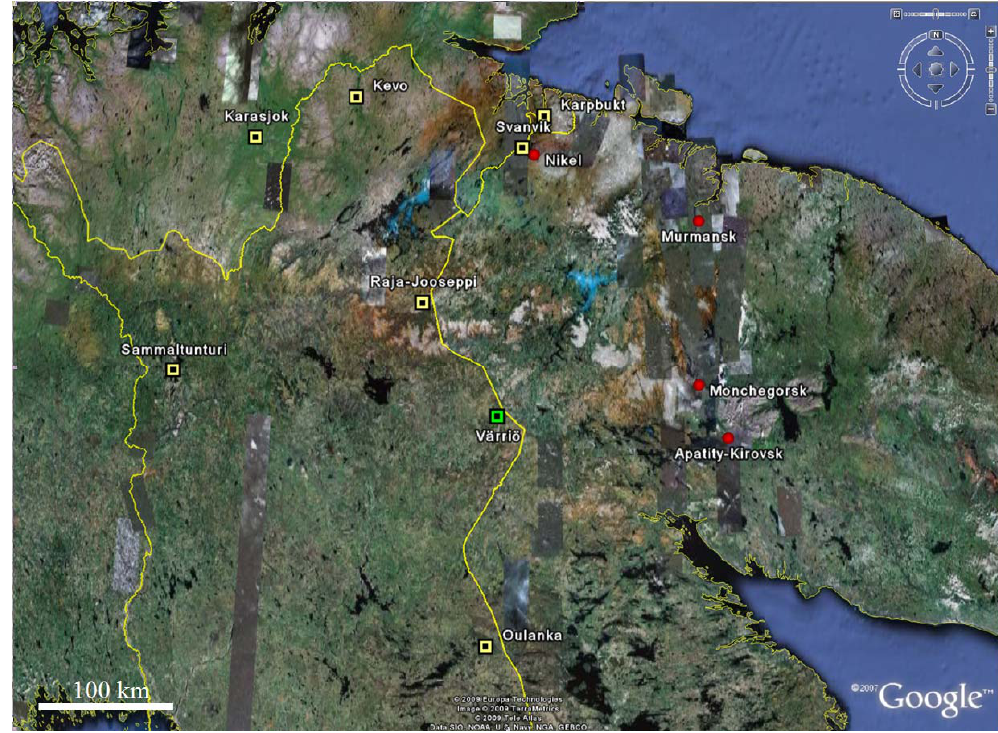
Figure 1. Location of the major pollution sources of Kola Peninsula (red circles), the Varrio measurement station (green rectangle) and the other measurement sites (yellow rectangles).